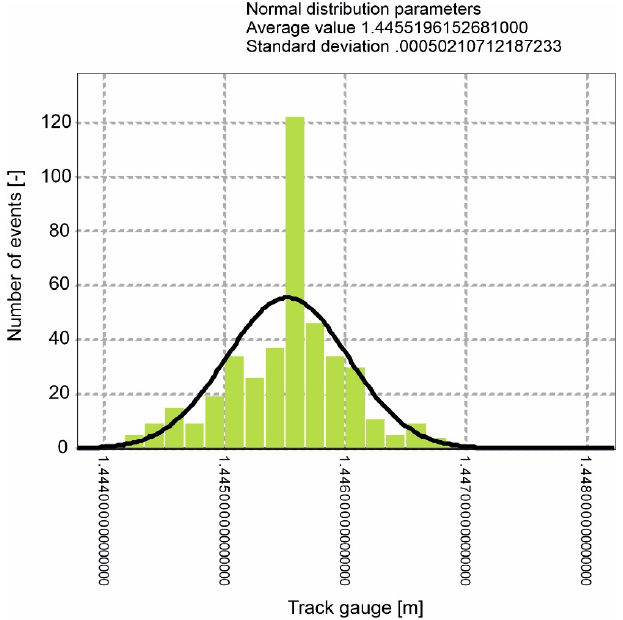
Figure 6. Track gauge normal distribution in the rail turnout. The step curve and distribution function were marked successively, as shown in Fig- ure 7.